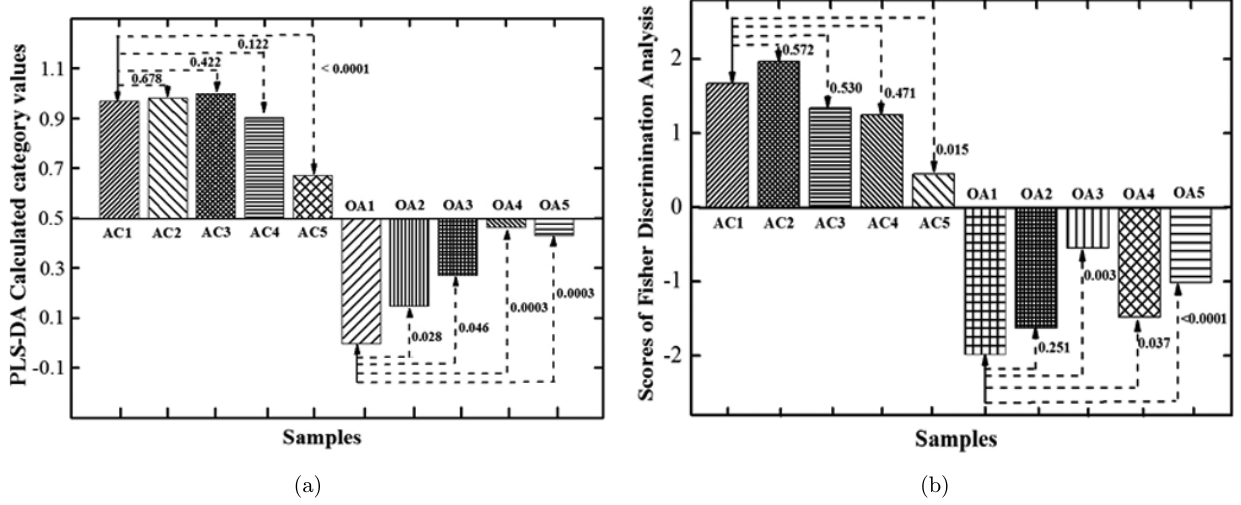
Fig. 5. Statistical analysis of PLS-DA categorical values (a) and the score values of PCA-FDA (b) for healthy and OA groups, respectively. The healthy cartilages were sequenced from AC1 to AC5, as well as the OA cartilages from OA1 to OA5. AC1 and OA1 were regarded as control in the corresponding group for statistical analysis, respectively. Each of the arrow pair indicates the statistical analysis between the control and comparative samples where the corresponding p - value is given around the